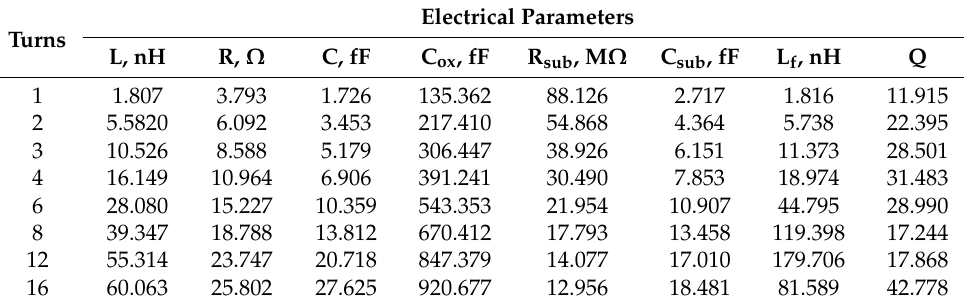
Table 1. Results of analysed square spiral inductors at 4